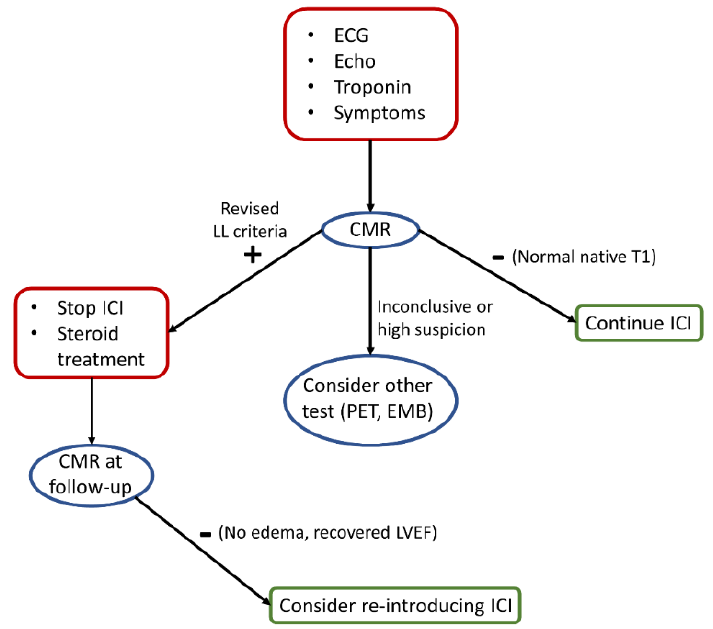
Figure 3. Proposed diagnostic algorithm for the evaluation of patients with suspected ICI-M. We hypothesize a CMR-centered algorithm, with the examination promptly performed according to clinical red flags (red square on top). Results from the CMR examination can further guide the diagnostic work-up, with other second-line tests potentially available in the case of inconclusive findings. The prognostic relevance of CMR biomarkers might be used as gatekeepers for a further re-challenge with ICI.